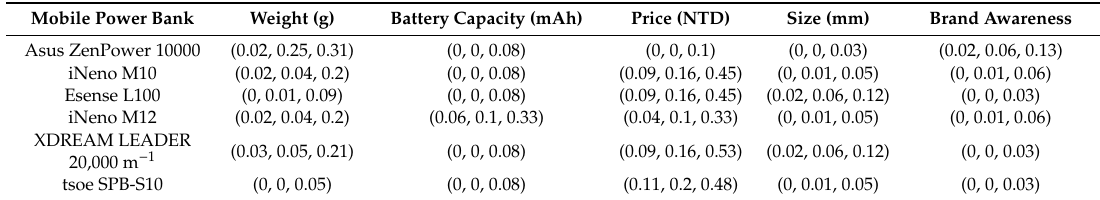
Table 5. Fuzzy weighted scores.